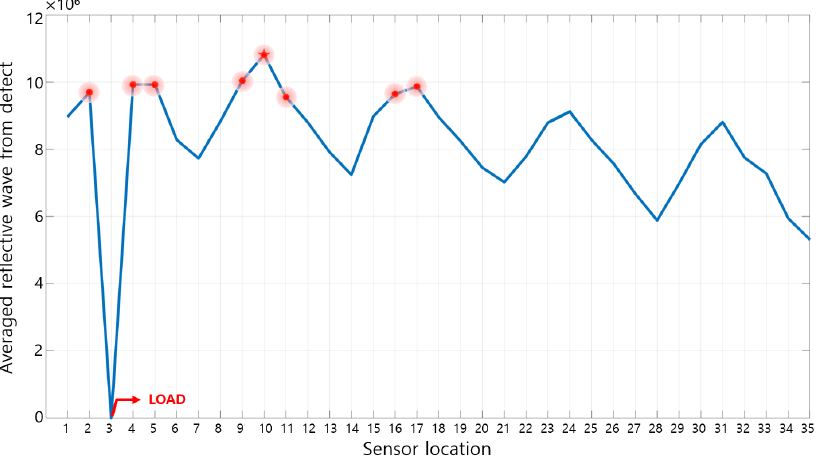
where a n is the n - th largest averaged amplitude of the reflected waves measured for each sensor . Figure 11. Averaged magnitude of the reflective waves from defects measured by each sensor.